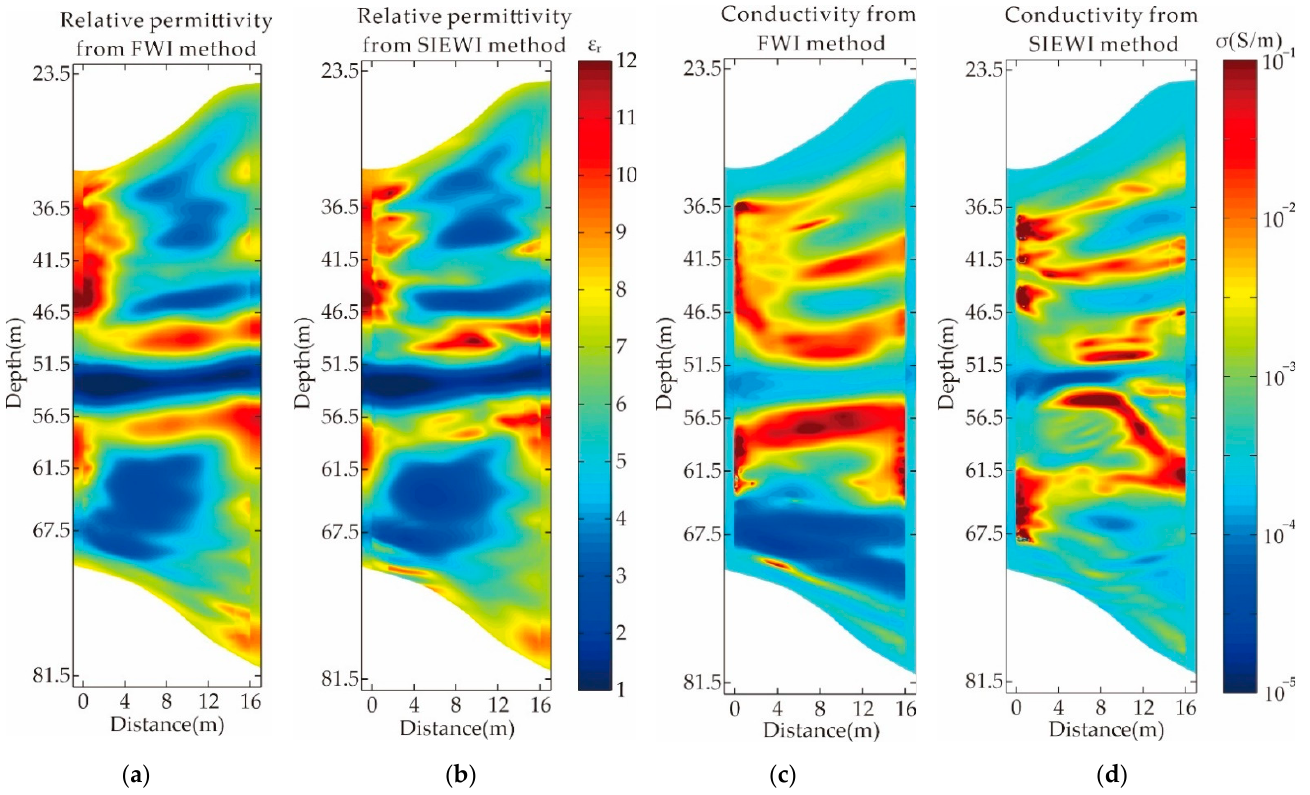
Figure 12. Inversion results of real data from Xiuyan. Inversion results based on FWI: ( a ) relative permittivity and ( c ) conductivity; inversion results based on SIEWI: ( b ) relative permittivity; ( d ) conductivity.